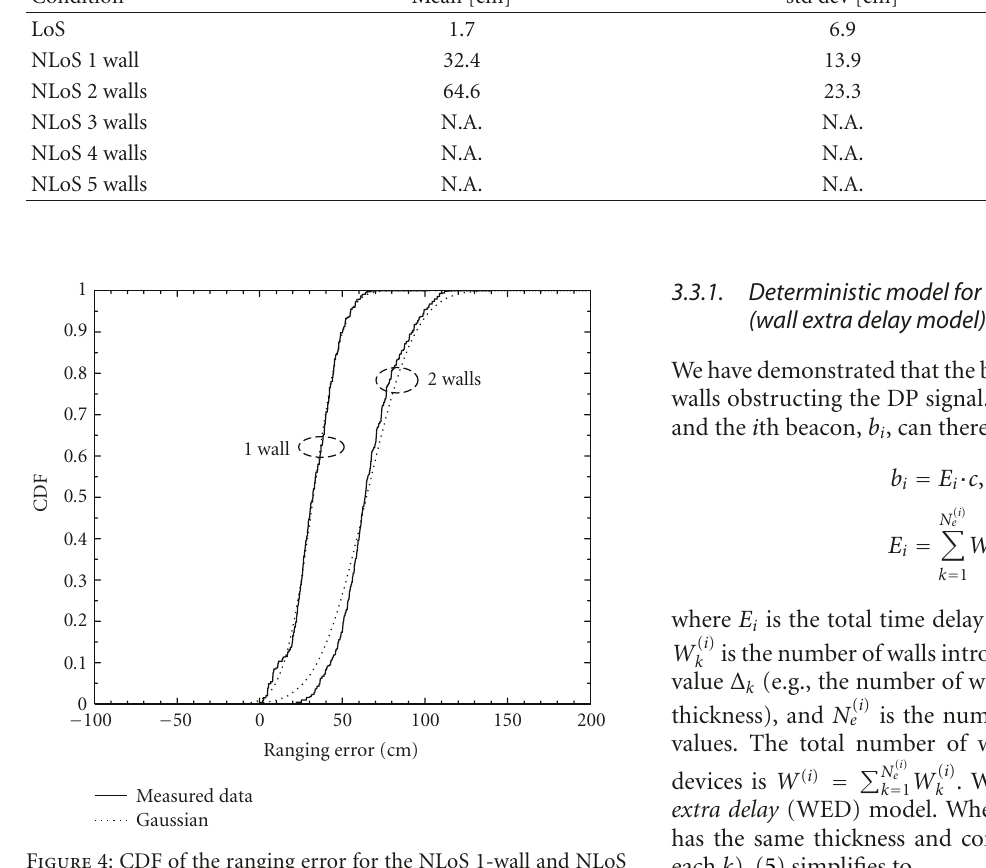
Figure 4: CDF of the ranging error for the NLoS 1-wall and NLoS 2-wall conditions. Comparison with the Gaussian